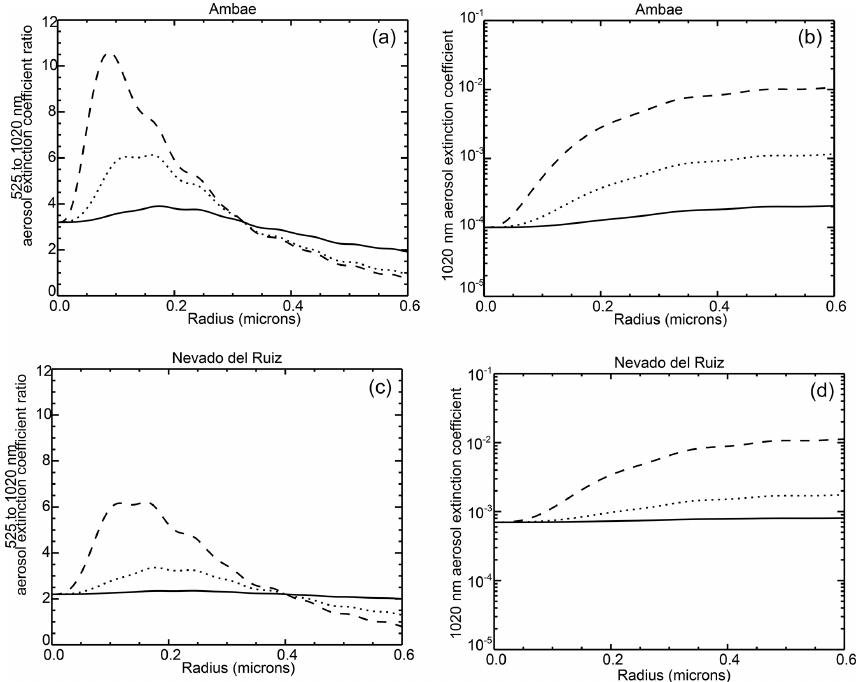
Figure 11. The estimated 525 to 1020nm aerosol extinction ratio and the 1020nm aerosol extinction coefficient for the second Ambae eruption (a, c) and Nevado del Ruiz (b, c) computed using fixed aerosol volume density perturbations and single-radii particles that yield an extinction coefficient perturbation at 525nm of 10 − 4 (solid), 10 − 3 (dotted), and 10 − 2 km − 1 (dashed) using rough “before” 525 and 1020nm extinction coefficient values for each